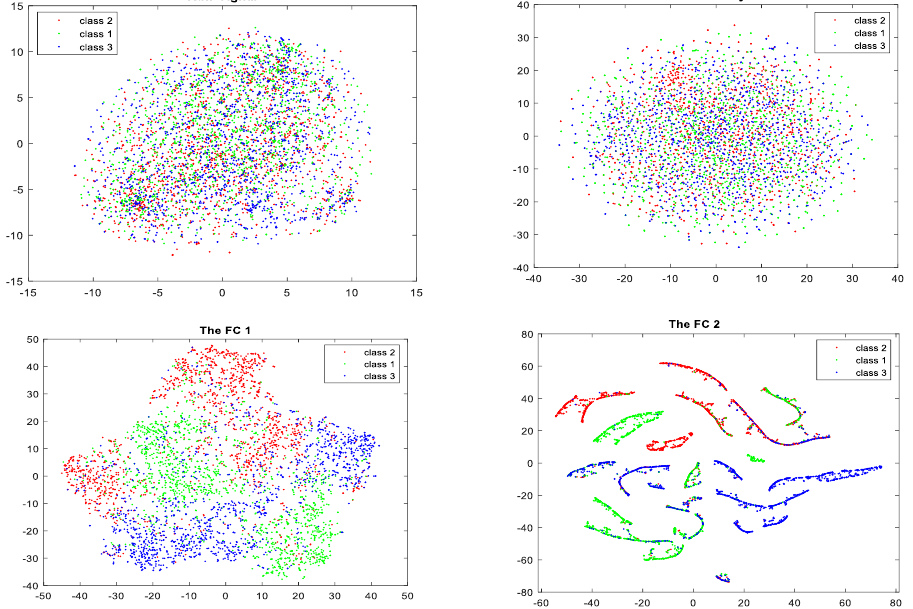
Figure 12. The T-Sen chart of the proposed method for three-class scenarios for F3 and C3 chan- nels.